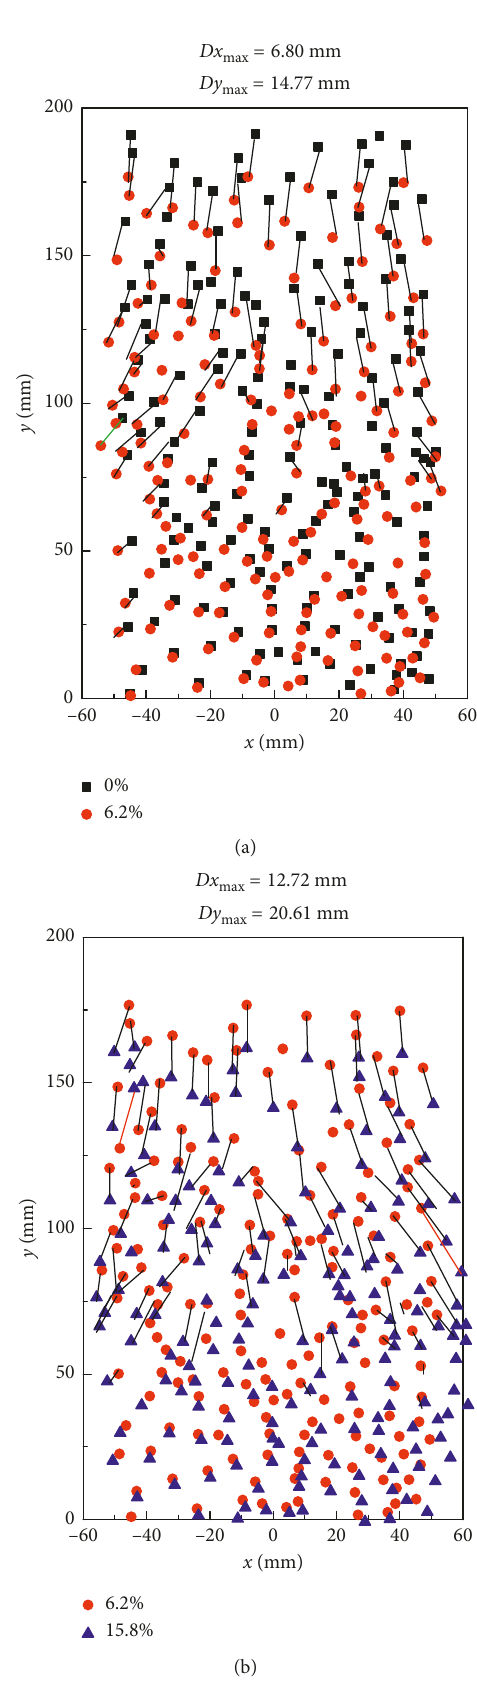
Figure 9: Displacement vector picture of